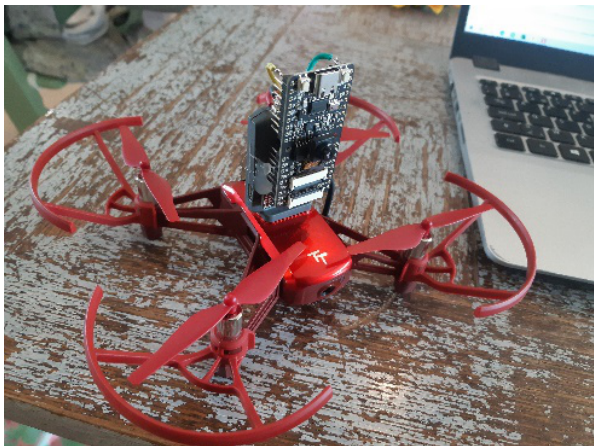
Figure 9. Our drone prototype carrying the Maix Bit.